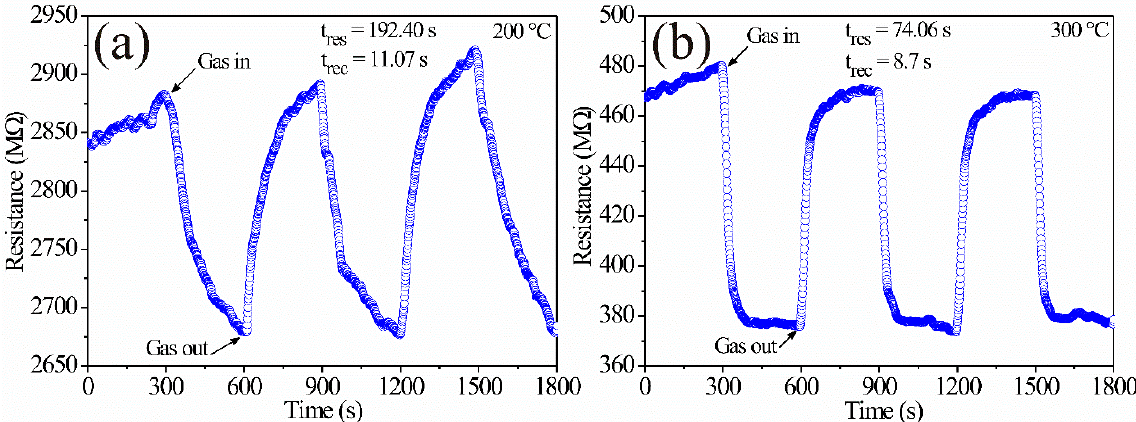
Figure 12. Dynamic response of ZnAl 2 O 4 thick films in air–propane atmospheres at temperatures: ( a ) 200 °C, ( b ) 300 °C.